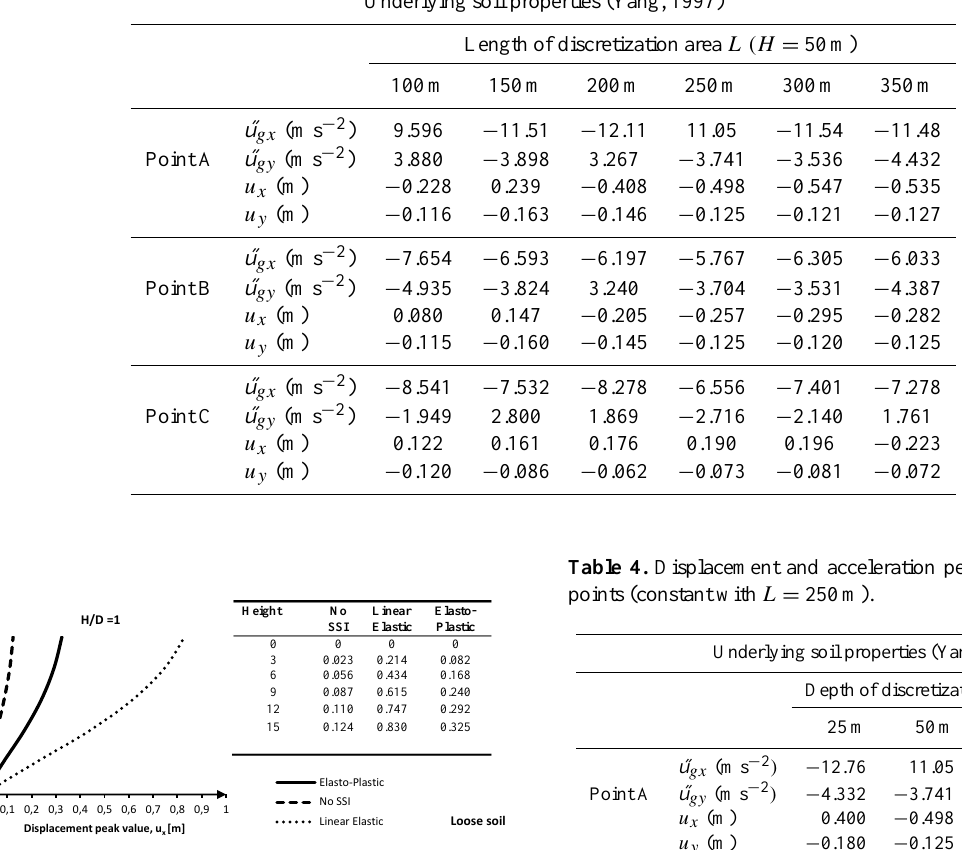
Table 3. Displacement and acceleration peak values for different points (constant with H = 50m). Underlying soil properties (Yang, 1997)